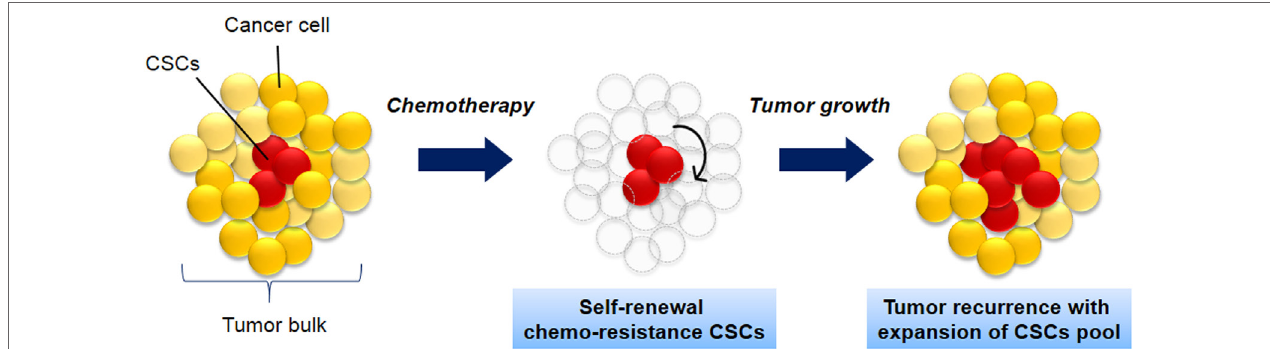
FigURe 1 | The biology of cancer stem cells (CSCs) . CSCs (red) self-renew and differentiate within tumors to form CSCs pool and non-tumorigenic cancer cells (yellow), which have limited proliferative potential. As the tumor grows, these cells can either undergo limited benign growth or form disseminated malignancies. These cells are resistance to chemotherapy and leads to cancer